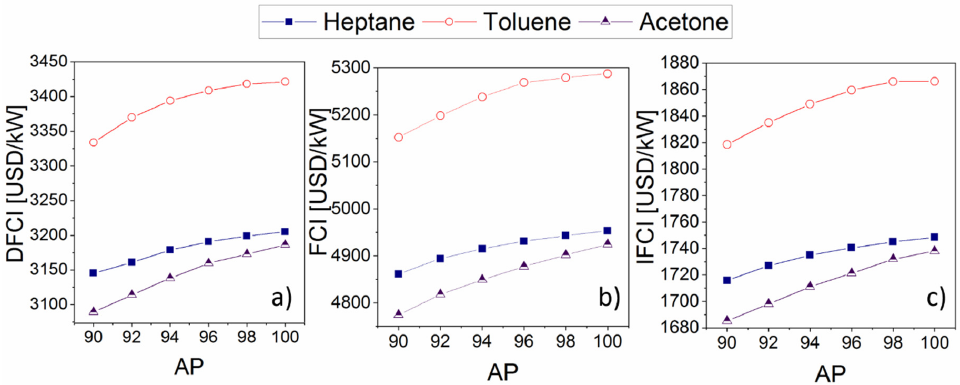
Figure 8. Effect of evaporator pinch point on investment costs for a RORC system varying ( a ) DFCI, ( b ) FCI, and ( c ) IFCI.